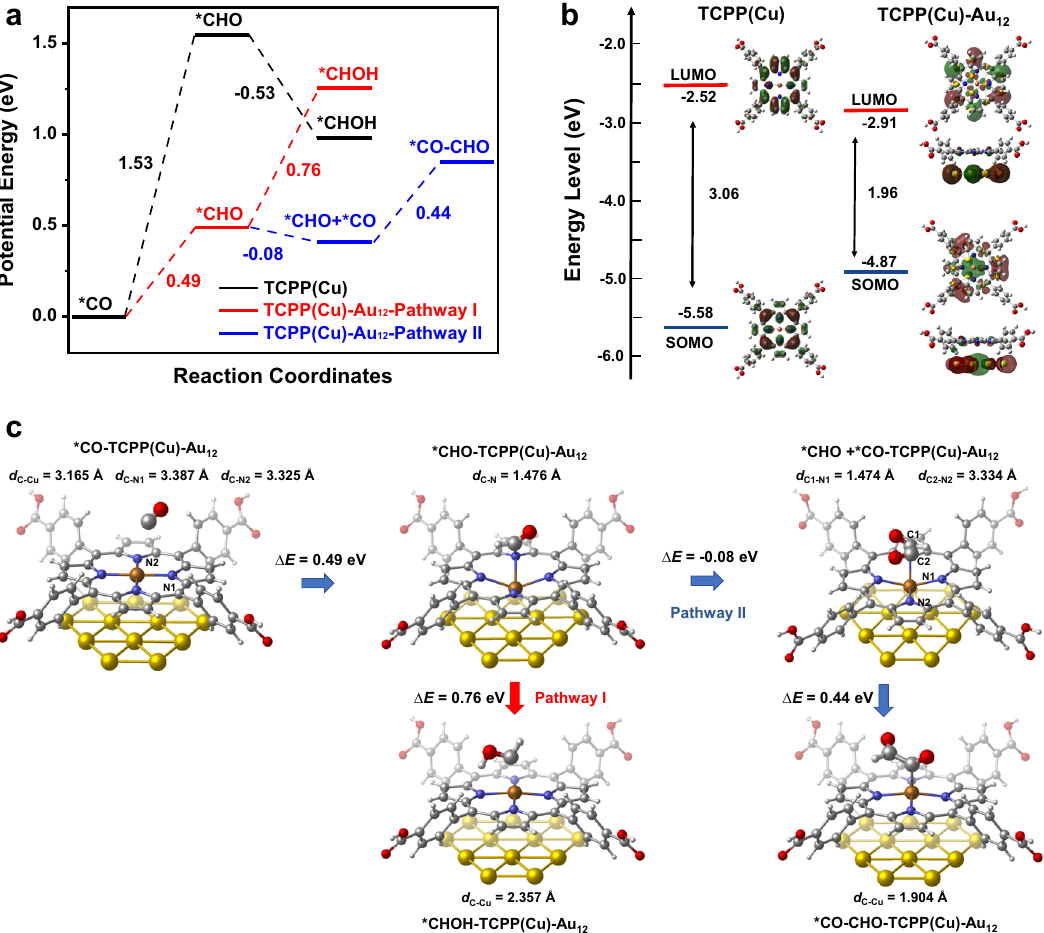
Fig. 7 DFT calculations of the con fi guration and energetics of key intermediates involved in the C1 and C2 paths. a The formation energy of key intermediates along with the reaction coordinates for TCPP(Cu) and TCPP(Cu)-Au 12 . b Calculated energy levels of HOMO and LUMO for TCPP(Cu) and TCPP(Cu)-Au 12 . c Con fi guration of intermediates absorption on TCPP(Cu)-Au 12 . The colors are C in silver, H in white, O in red, N in blue, Au in yellow, and Cu in